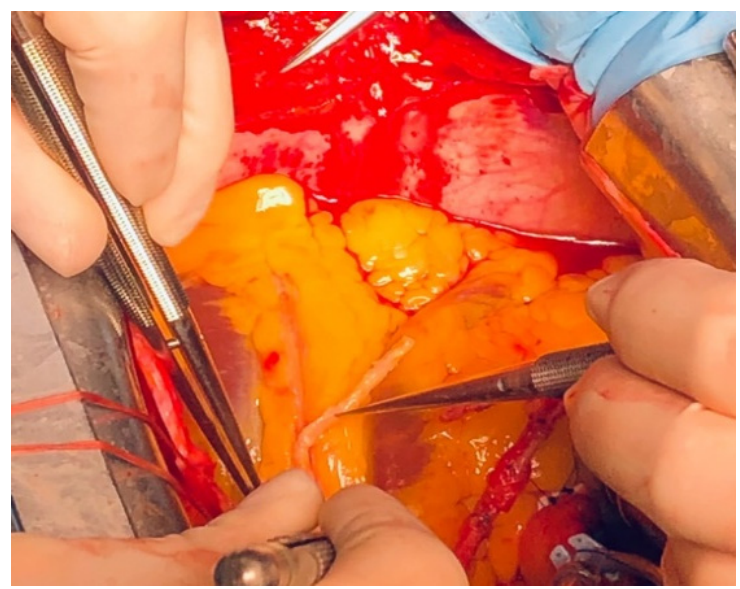
Figure 3. Extracting the plaque “en bloc”.